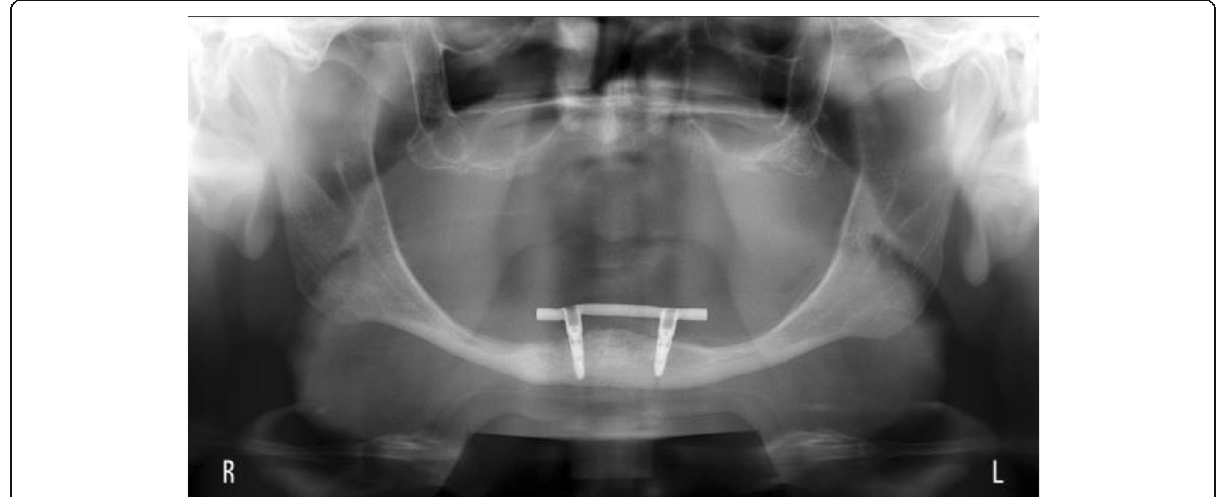
Fig. 2 Rotational panoramic radiograph at the time of the evaluation visit of a patient of the 2-implant